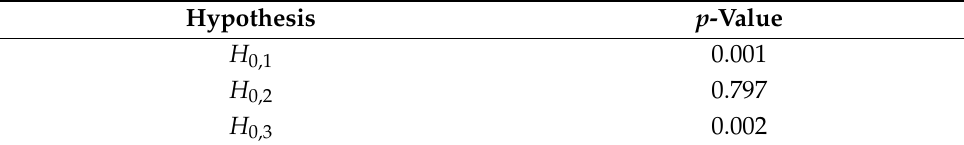
Table 8. p -value obtained for each of the hypotheses evaluated.